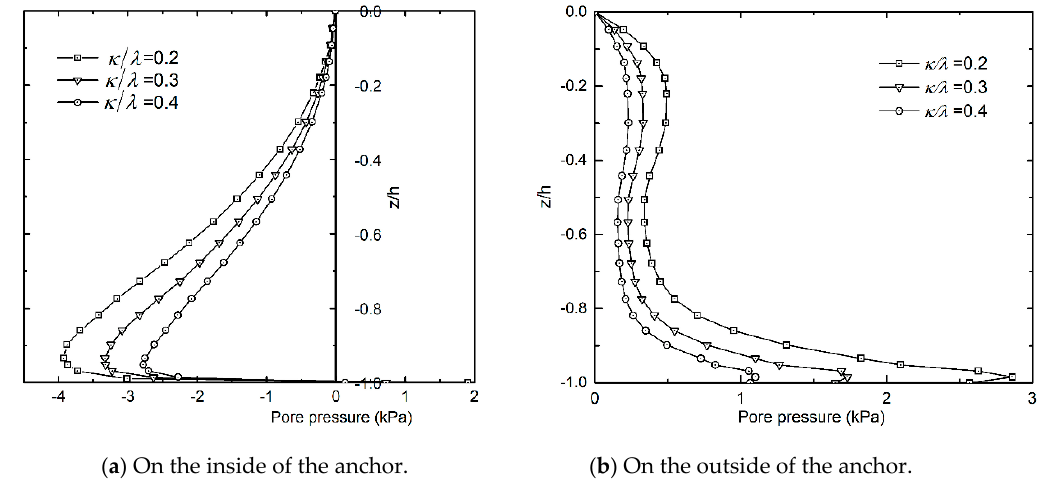
Figure 14. Vertical distribution of the residual pore pressures within the seabed along the anchor wall for various κ / λ .